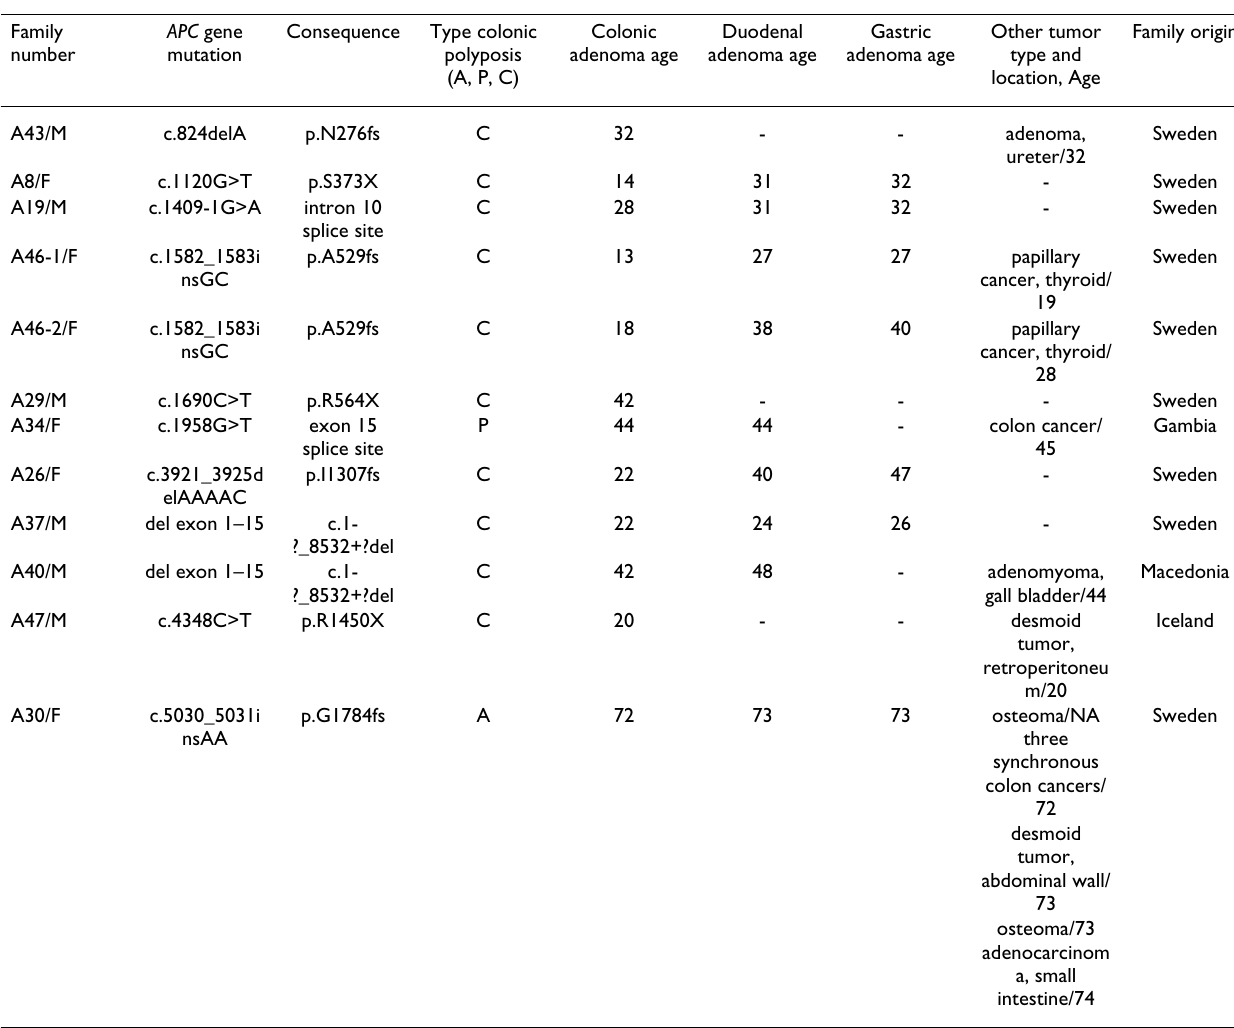
Table 1: Summary of genotypes and phenotypes Family